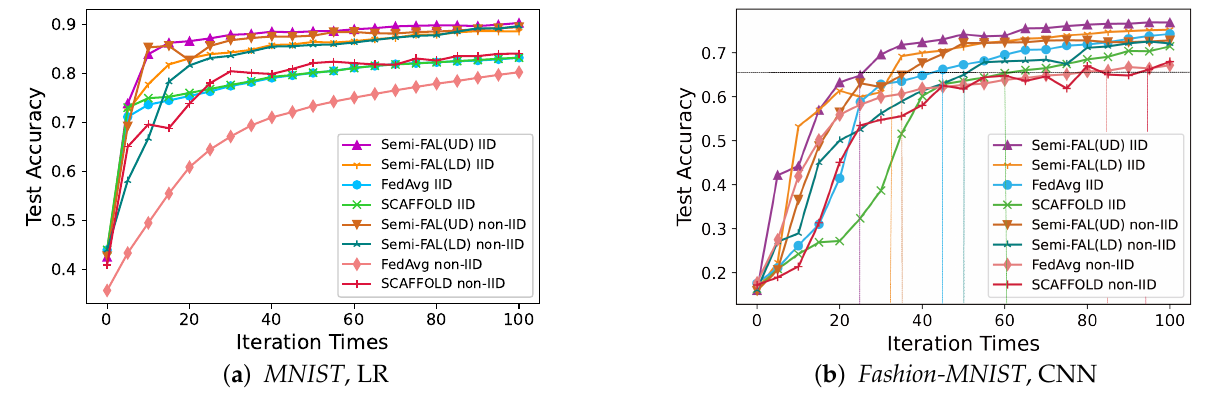
Figure 3. The result of the case study: test accuracy vs. iteration rounds for the MNIST, LR and FEMNIST, CNN in IID and non-IID data